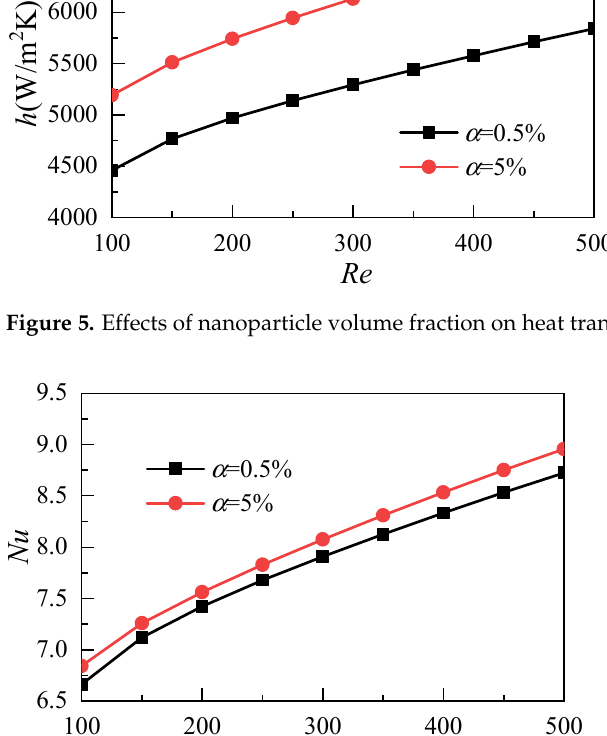
Figure 5. Effects of nanoparticle volume fraction on heat transfer coefficients.